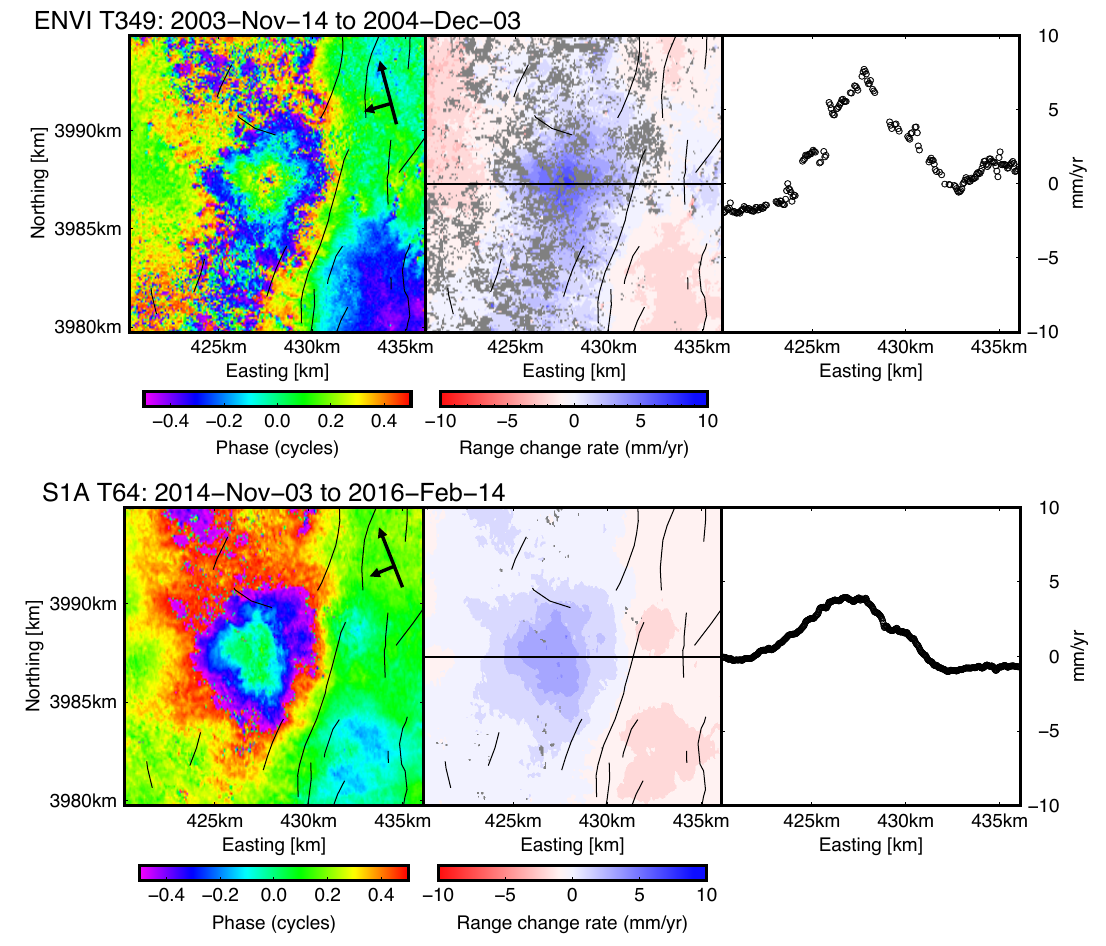
Figure 3. Example interferograms from Envisat and Sentinel-1A satellites spanning the production interval. For each pair (row), the left panel shows wrapped phase in cycles, the middle panel shows range change rate in mm/year, and the right panel shows values of range change rate in mm/year taken along the profile (thick black line in the middle panel). The incidence angle (denoted as the small arrow in the northeast of the phase plot) is 21.1 ◦ and the azimuth (from North, denoted as the large arrow in the northeast corner of the phase plot) is − 11.0 ◦ for Envisat pairs. The incidence angle is 33.9 ◦ and the azimuth is − 13.1 ◦ for Sentinel-1A pairs. One cycle of color in wrapped phase corresponds to 28 mm of range change. Plotting conventions as in Figure